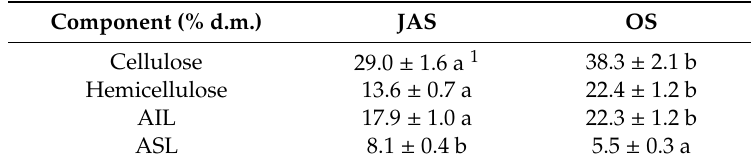
Table 1. Chemical composition of raw JAS and